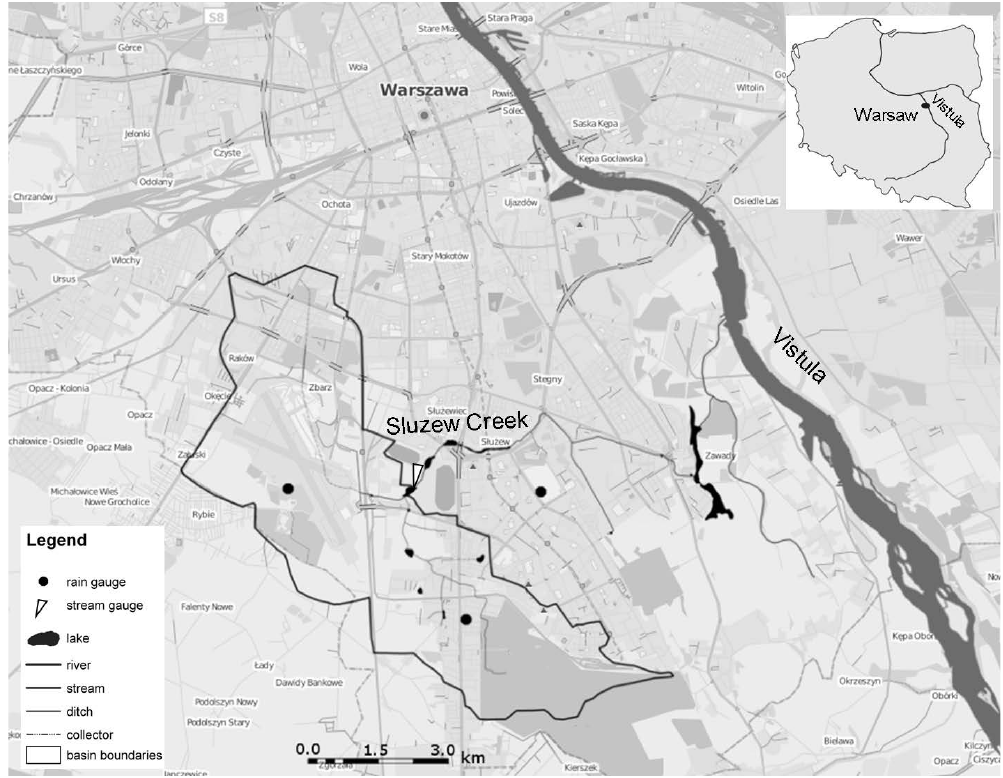
Fig. 2. Overview of the Sluzew Creek catchment, Warsaw,